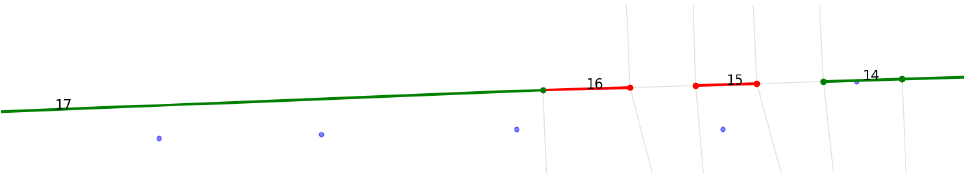
Figure 11. Model outcome for Cat-III error : discrete jumps in Dataset